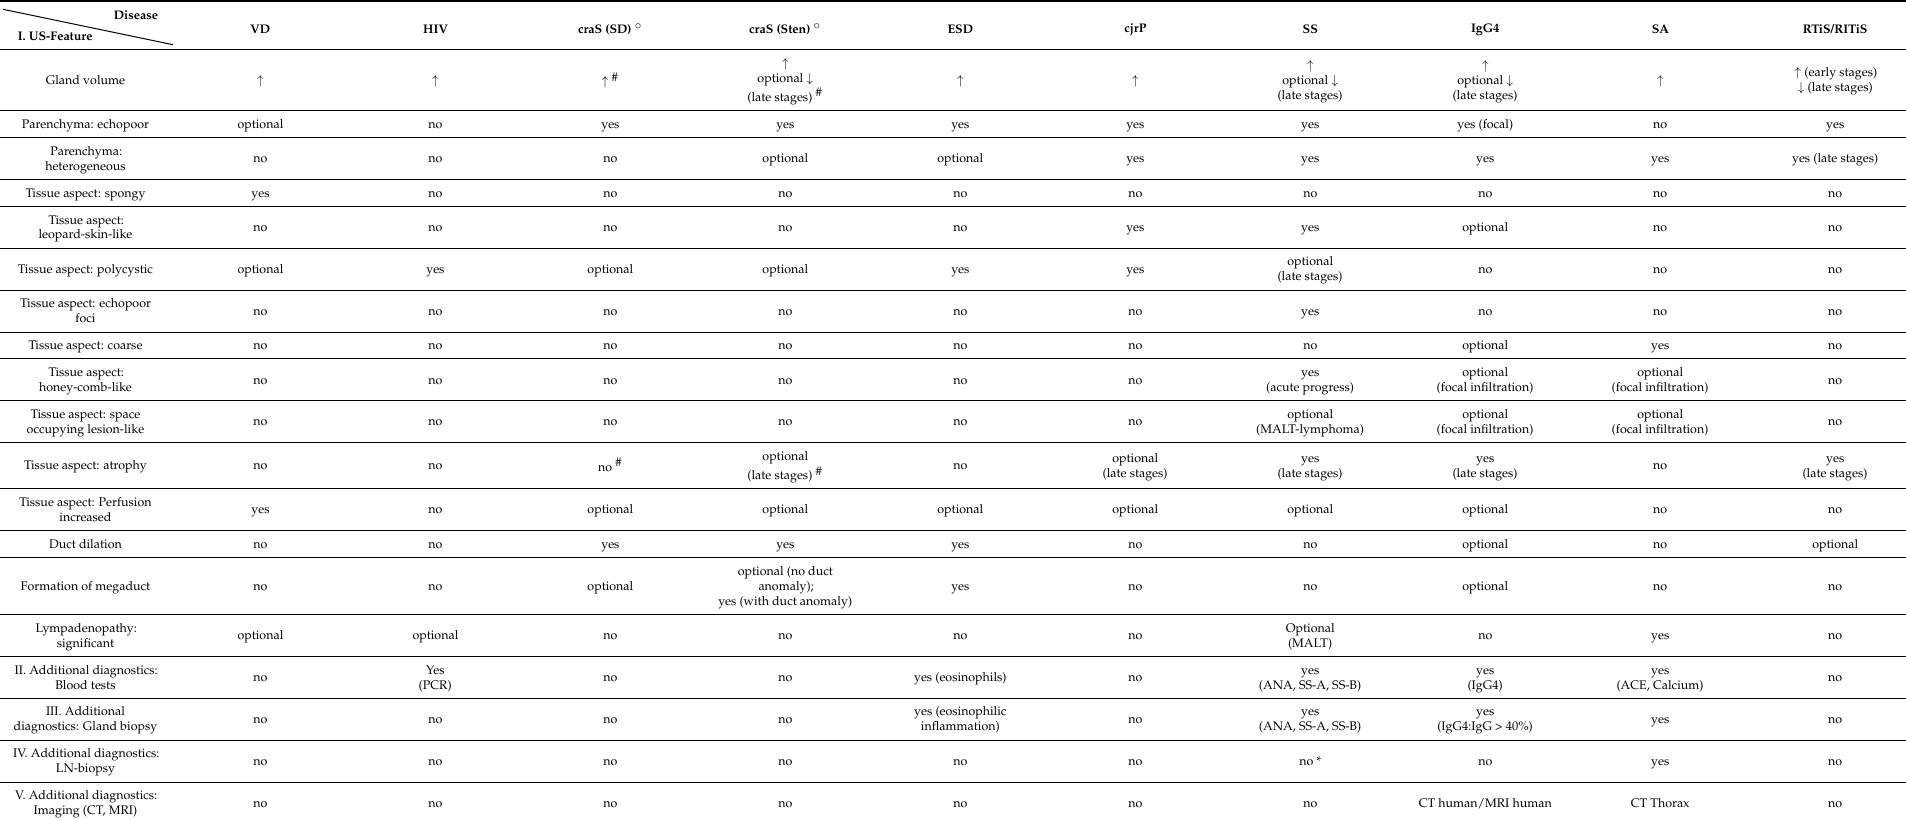
Table 2. Important US features in non-sialolithiasis caused infectious, inflammatory, obstructive diseases in salivary glands. Limits of US diagnosis are indicated by additional diagnostics